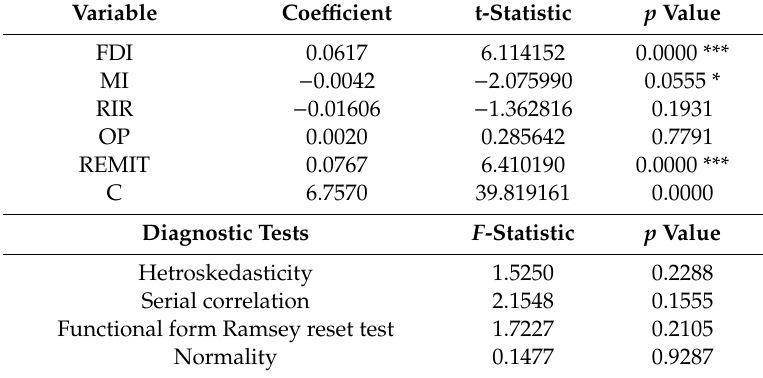
Table 5. Long-run estimated coe ffi cient using the autoregressive distributed lag (ARDL) model (1, 0, 0, 1, 2, 2).